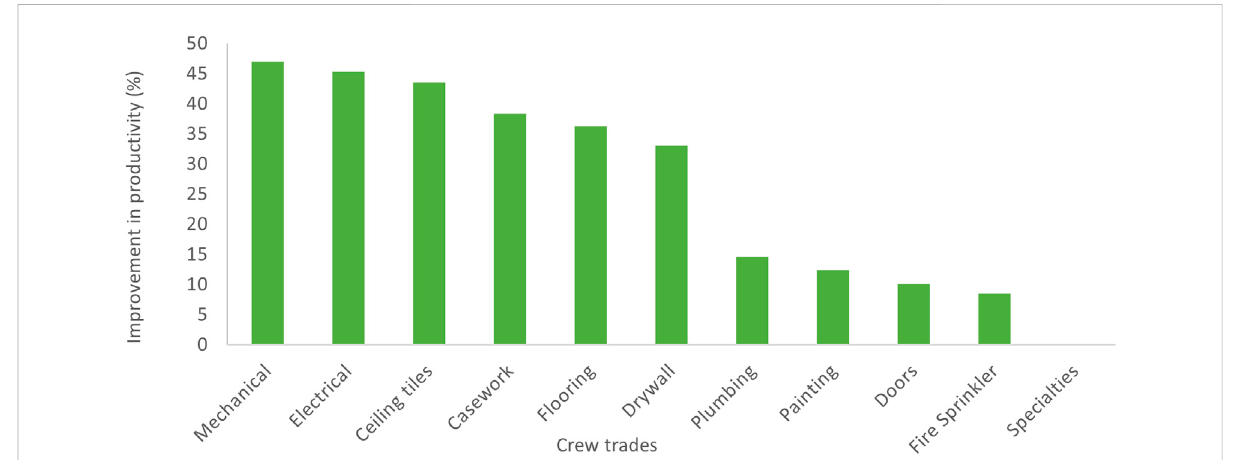
FIGURE 12 Improvement in the average productivity of all crew types from push to pull